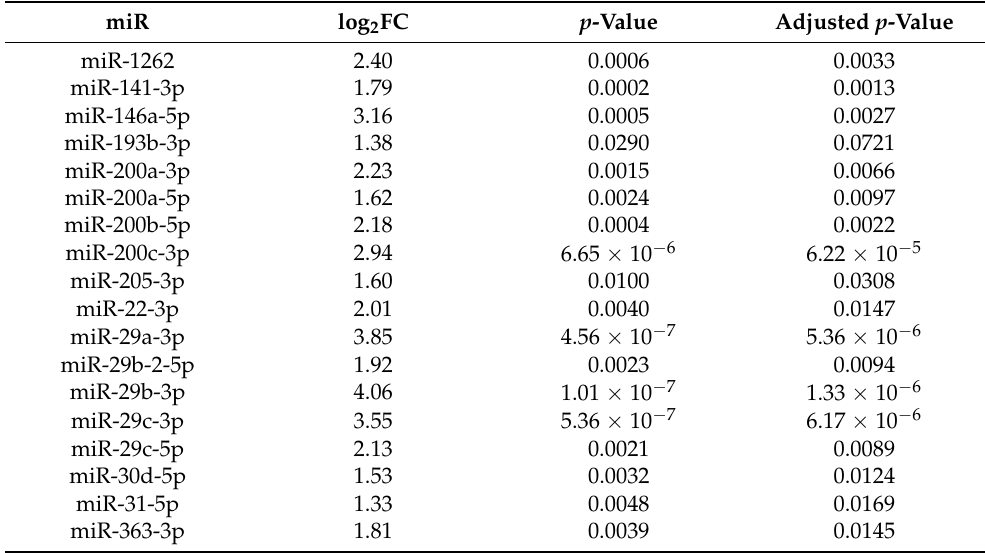
Table 2. Urine cfmiRs down-regulated in post-operative samples that were also differentially ex- pressed between pre-operative PCa and NHD